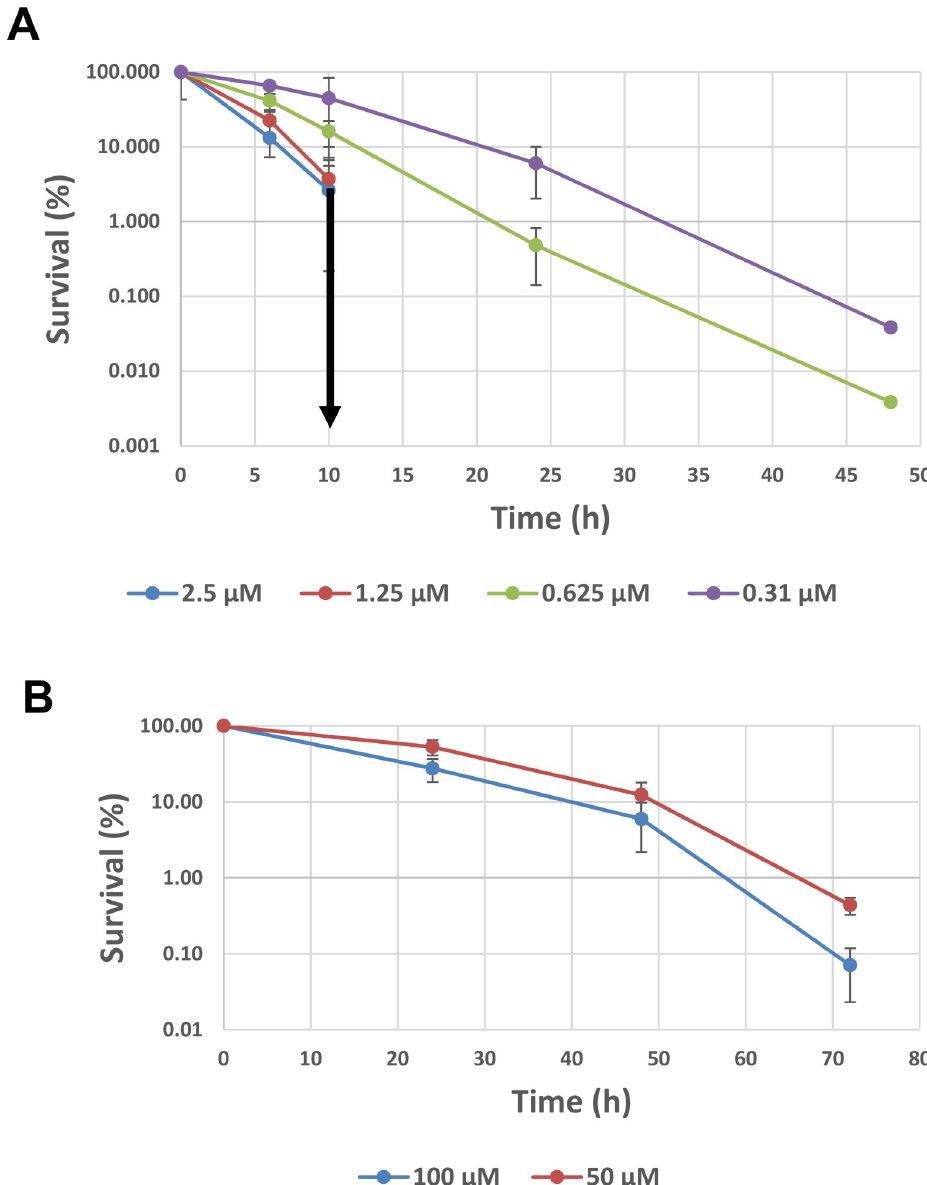
Fig 2. Bactericidal effect of FP-11g on M . smegmatis mc2 155 and M . abscessus . (A) The bactericidal effect of FP- 11g on M . smegmatis were determined using 1X (0.31 μ M), 2X (0.62 μ M), 4X (1.25 μ M) and 8X (2.5 μ M) MIC at different time points. The downward arrow indicates that no viable colonies were detected following treatment with 4X and 8X MIC at time points beyond 10 hours. (B) Survival of clinical isolate of M . abscessus following treatment with FP-11g at 50 and 100 μ M. Percent survival is calculated by the ratio of cfu from treated culture versus cfu from culture prior to addition of FP-11g. The error bars represent the standard deviation of results of experiments repeated three